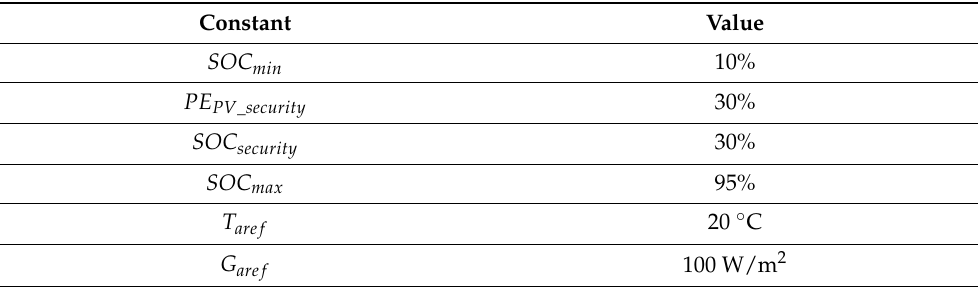
Table 4. Parameters of the management